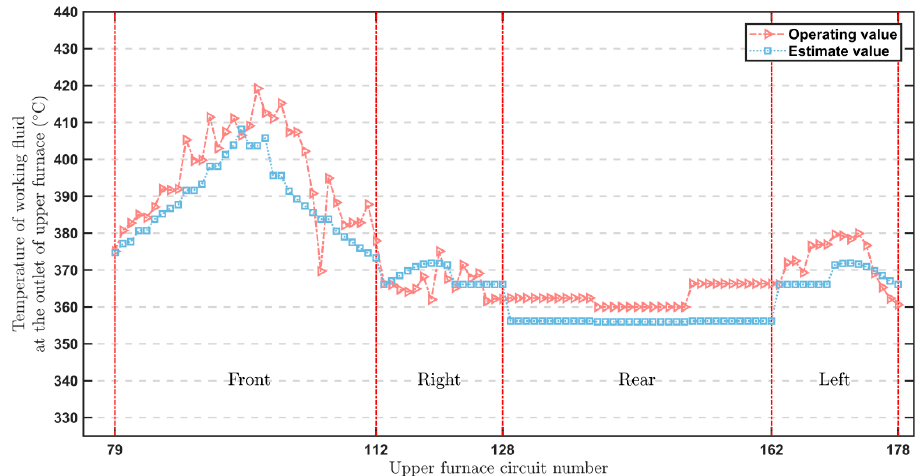
Figure 14. Comparison between calculated value of working medium temperature at outlet of upper furnace loop and field operation value